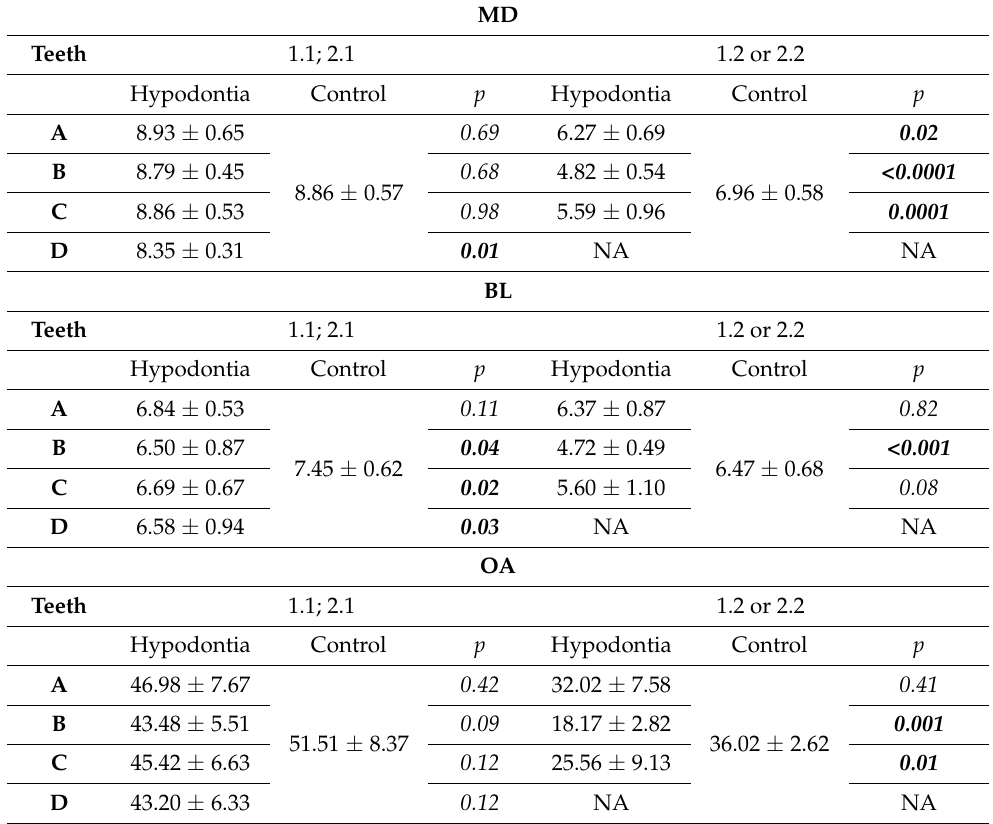
Table 4. Mean values of upper central incisors and upper lateral incisors (where they were present).